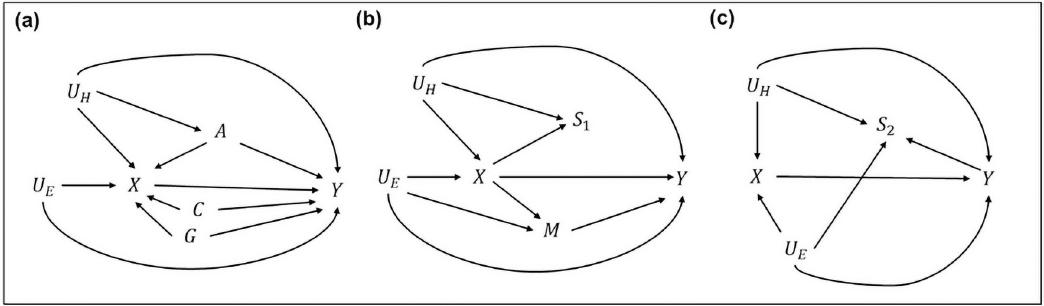
Fig 1. Directed Acyclic Graphs (DAGs) for the focal and the sensitivity analysis models. For clearer illustration, the DAGs in (b) and (c) do not include the paths related to A, C, G as presented in (a). These paths and variables, however, are applied across all three